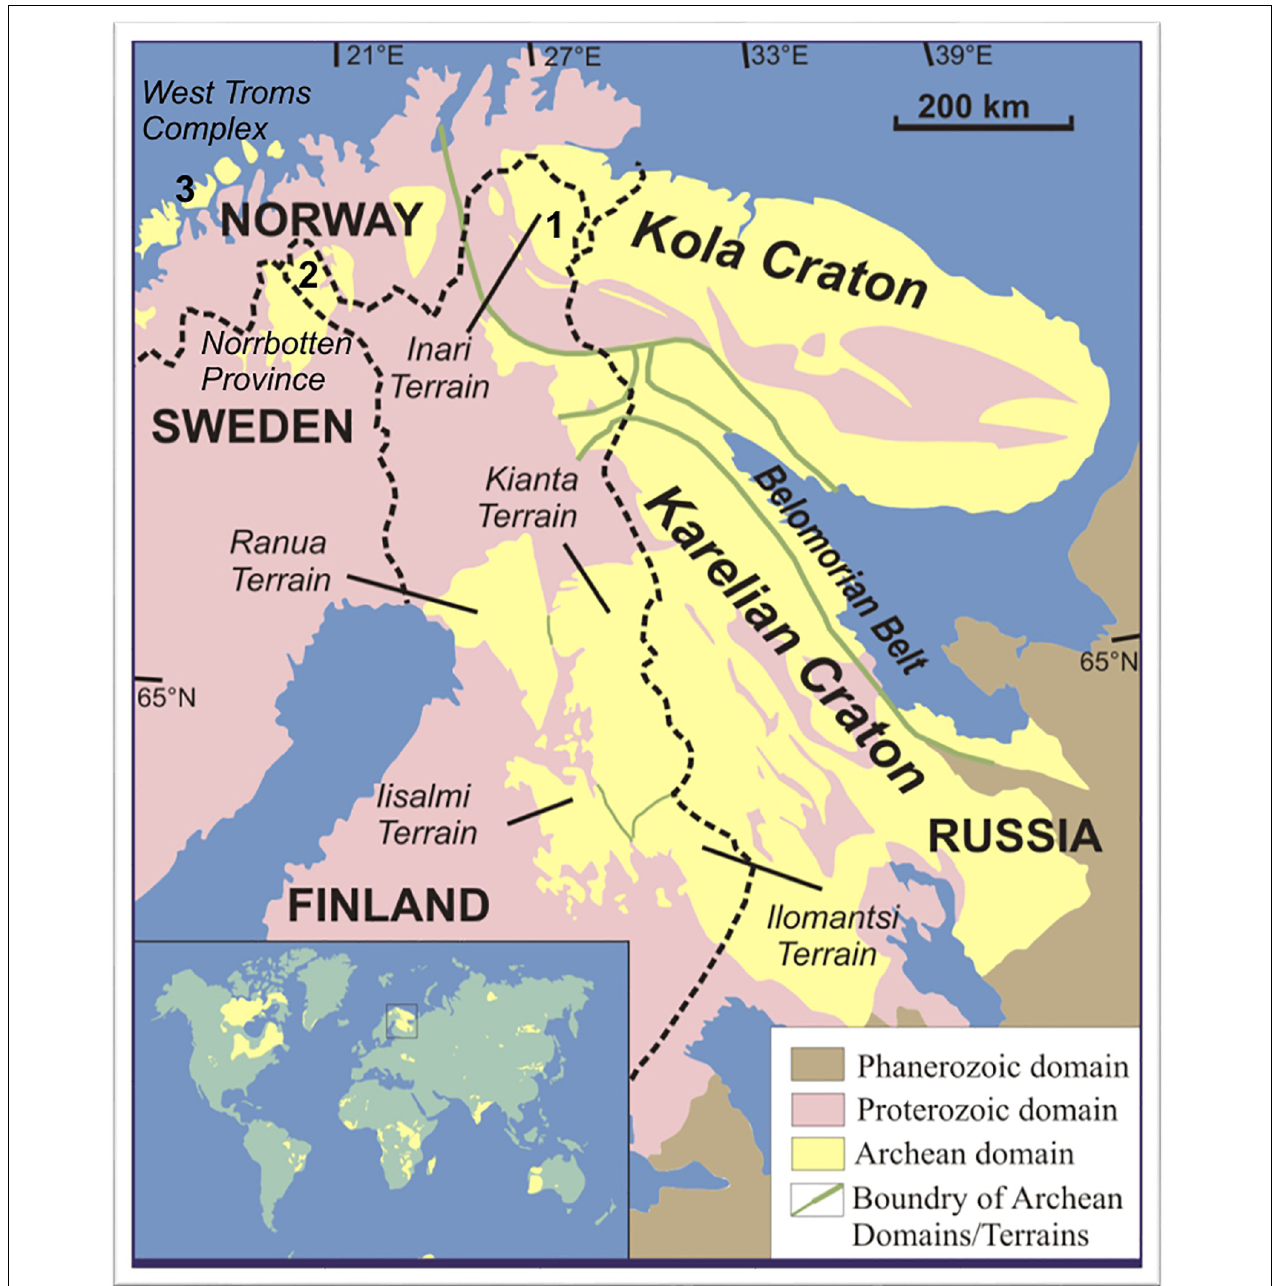
FIGURE 1 | Simplified map of the Fennoscandian Shield showing the locations of the TTG-amphibolite terrains of Arctic Fennoscandia. (1) Lake Inari Complex of the Kola Province, (2) Rommaeno Complex of the Norrbotten Province, and (3) the West Troms Complex (West Troms Basement